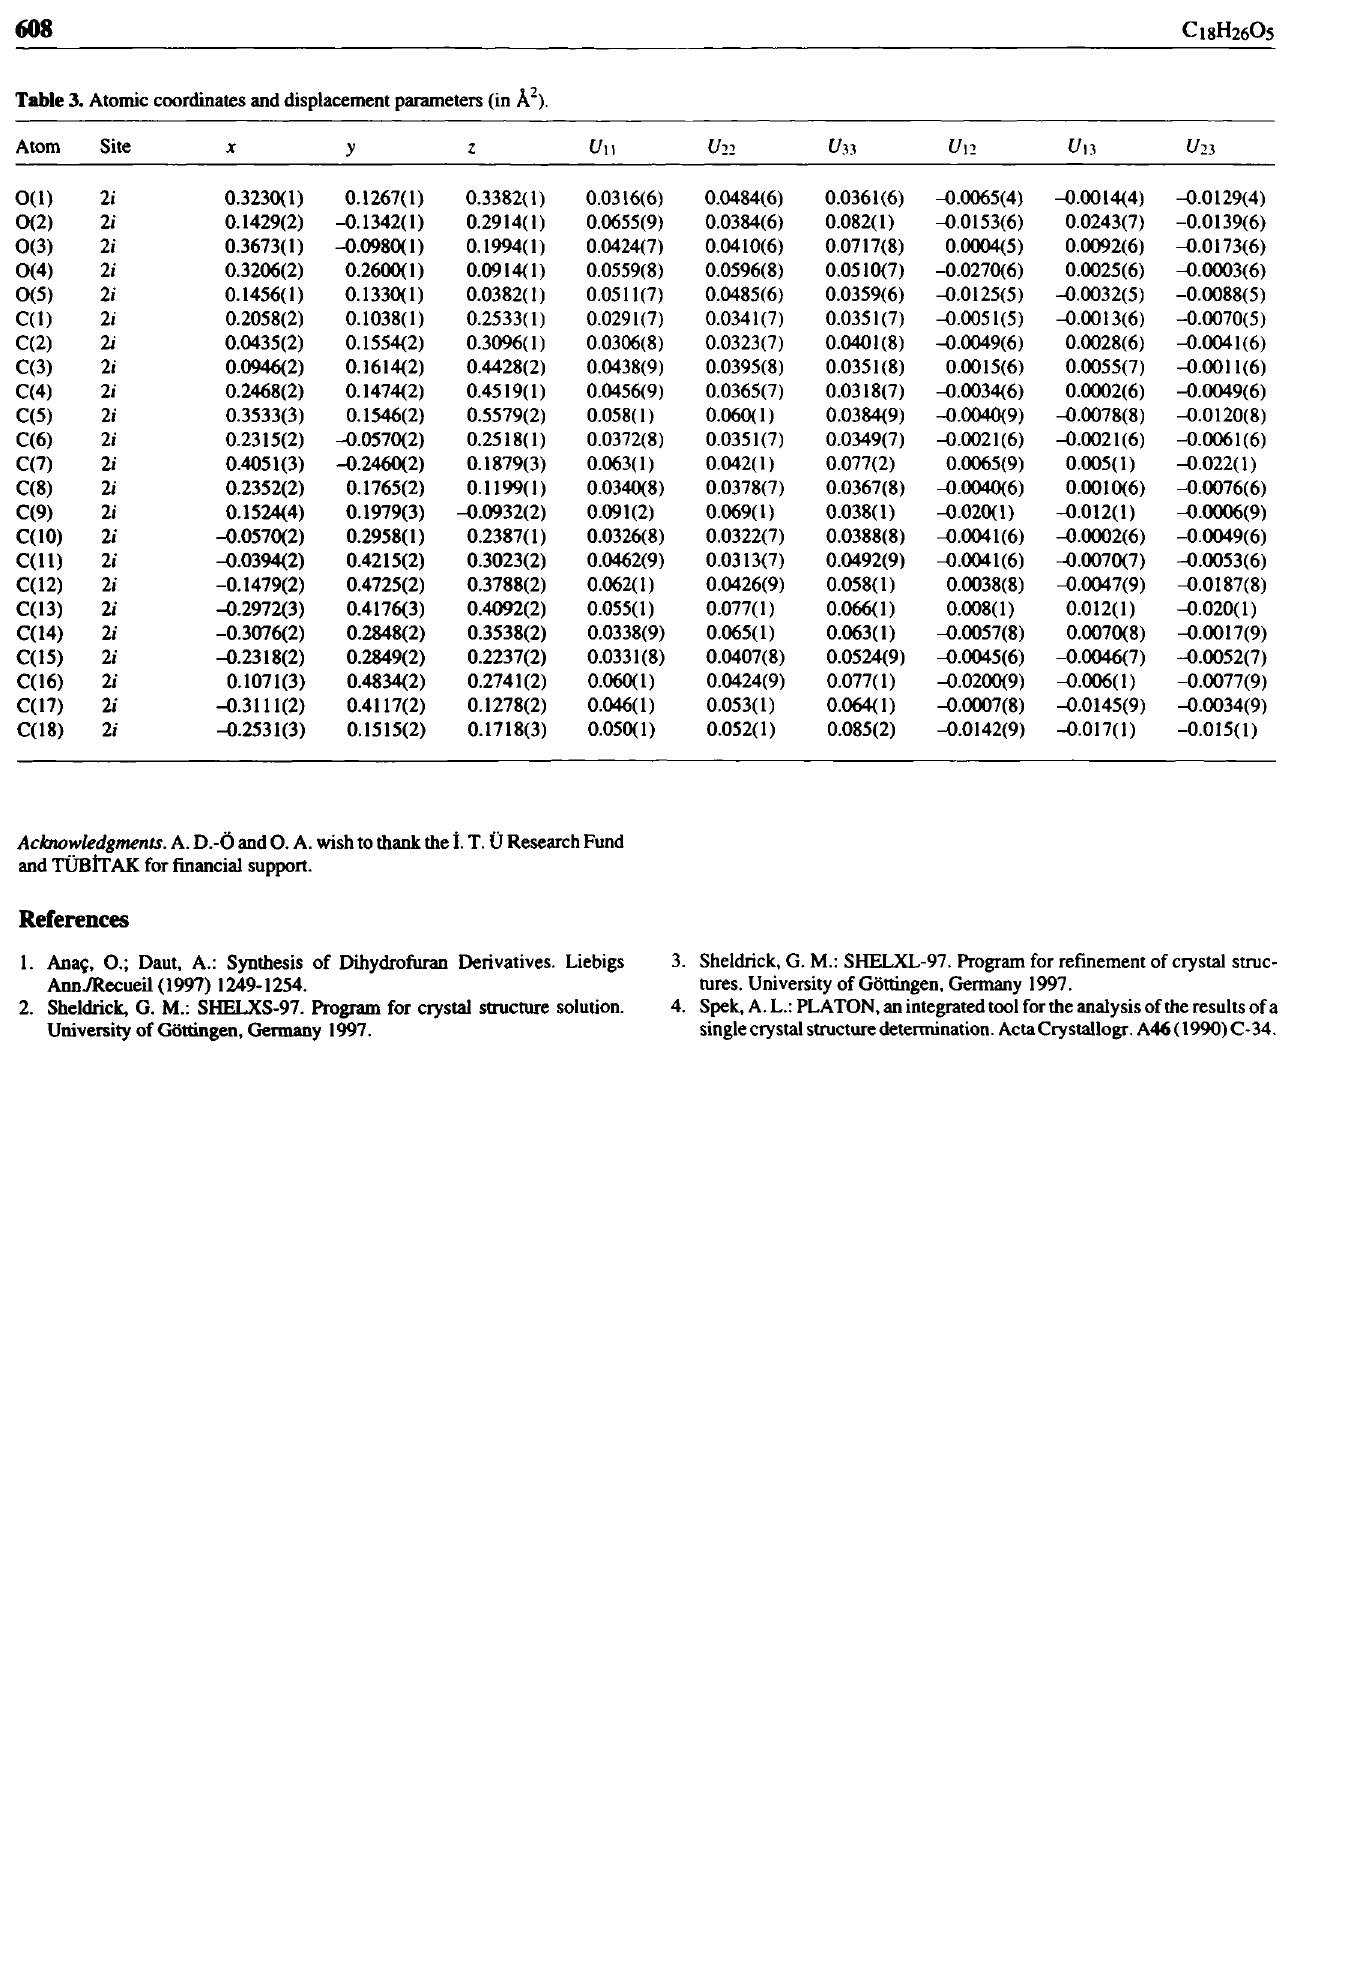
Table 3. Atomic coordinates and displacement parameters (in À 2